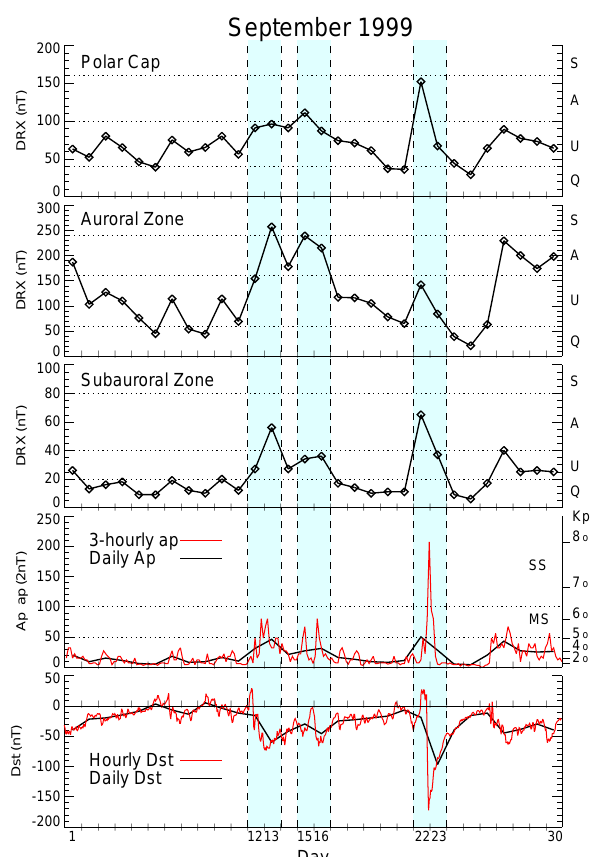
Fig. 2. Review of geomagnetic activity for September 1999. Plotted are the daily means of the hourly ranges of the x -component of the geomagnetic field (DRX) for the polar cap (Resolute Bay, 74.7 ◦ N, 94.9 ◦ W), auroral zone (Fort Churchill, 58.8 ◦ N, 94.1 ◦ W), and subauroral zone (Ottawa, 45.4 ◦ N, 75.6 ◦ W) in Canada, as well as the global magnetic indices of ap , A p , K p and D st . Since ap and K p are equivalent, the K p values can be read directly off the K p scale using the ap trace. The three time periods chosen for the case studies are shaded in blue. Q, U, A and S in the DRX plots refer to quiet, unsettled, active and stormy conditions, respectively. MS and SS next to the K p scale stand for major storm and severe storm,